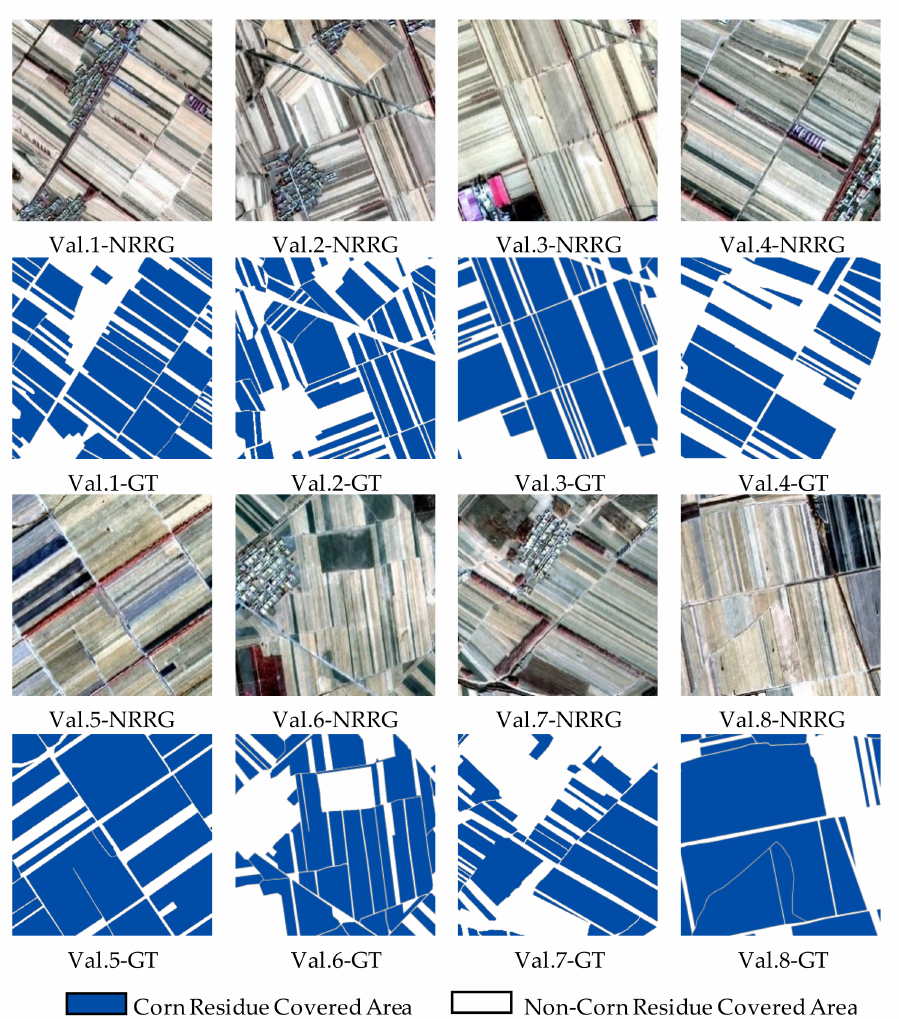
Figure 6. The eight validation (Val) samples (Near-infrared: Band 4, Red: Band 3, Green: Band 2) and corresponding ground truth (GT)